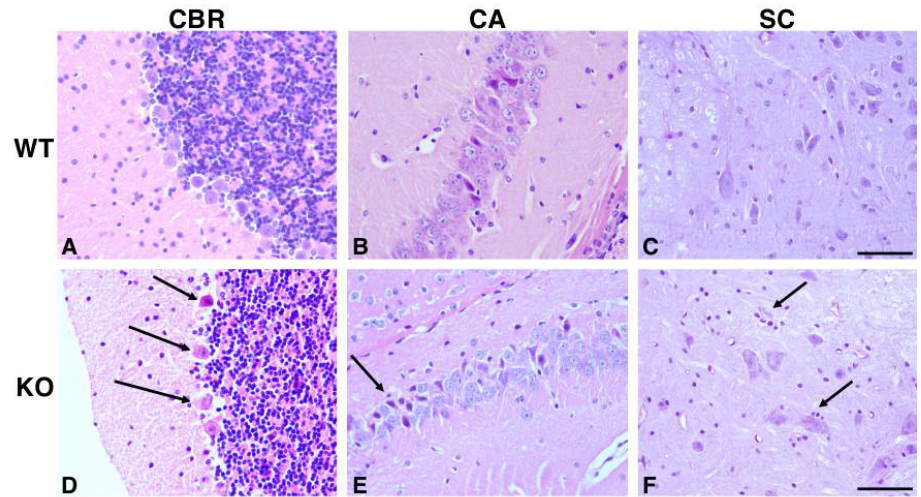
Figure 1. Histological analysis of the cerebellum (CBR), hippocampus (cornu ammonis) (CA), and spinal cord (SC) from 18-month-old wild-type (WT) and Hipk2 -KO (KO) mice. Representative images of H&E staining of WT ( A – C ) and KO ( D – F ) CBR, CA, and SC are shown. The arrows indicate neuronal loss ( D , E ) and satellite cells ( F ). Original magnification, 40×. Scale bar = 50 μm.